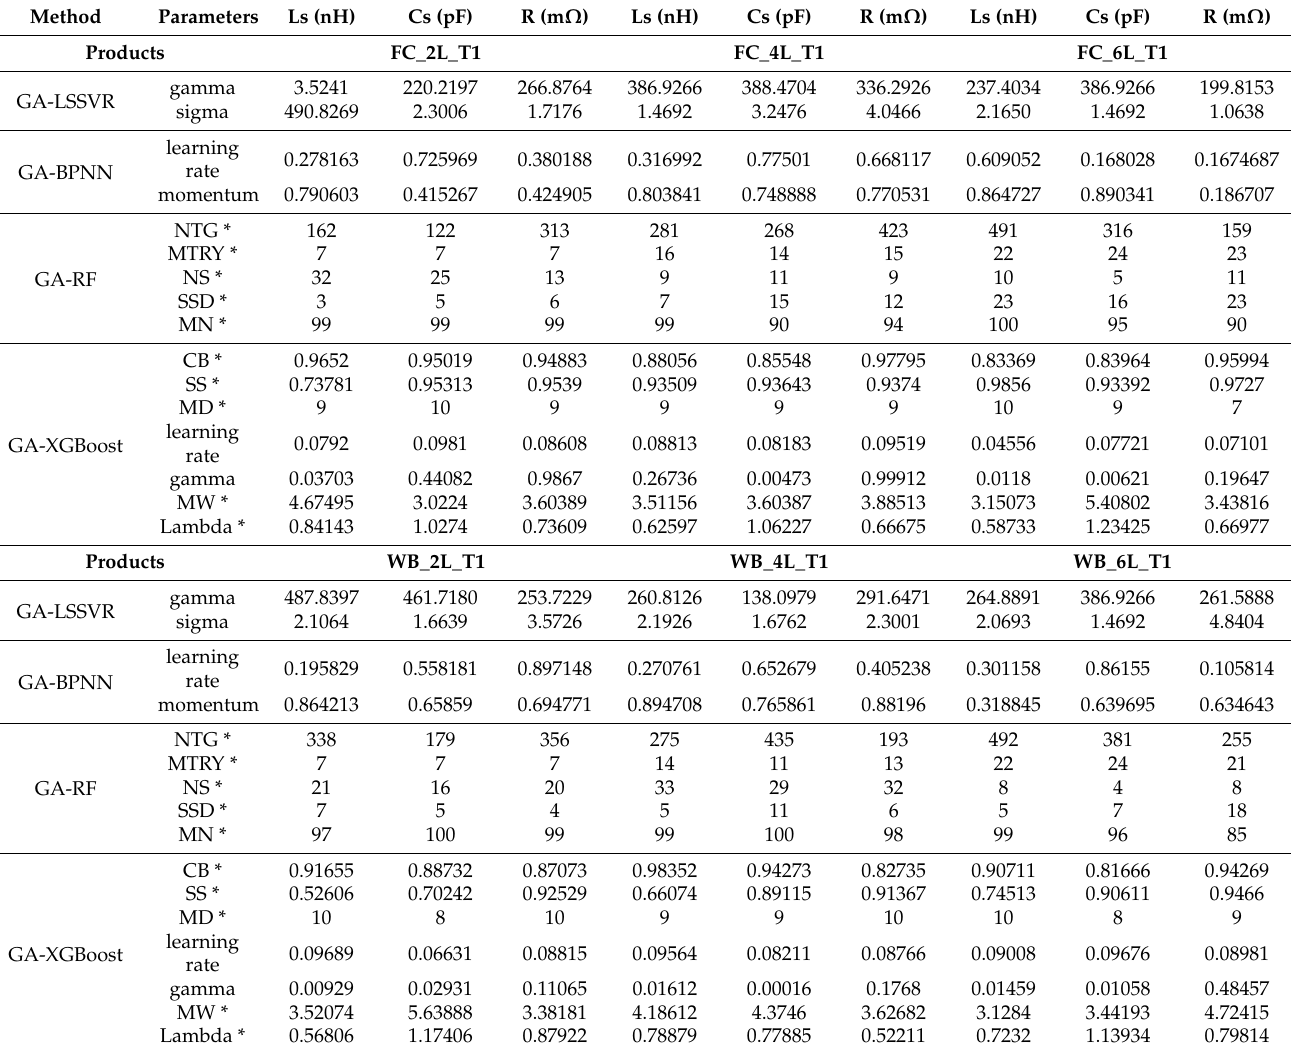
Table 3. Parameters of forecasting models provided by genetic algorithms in LCR values prediction.